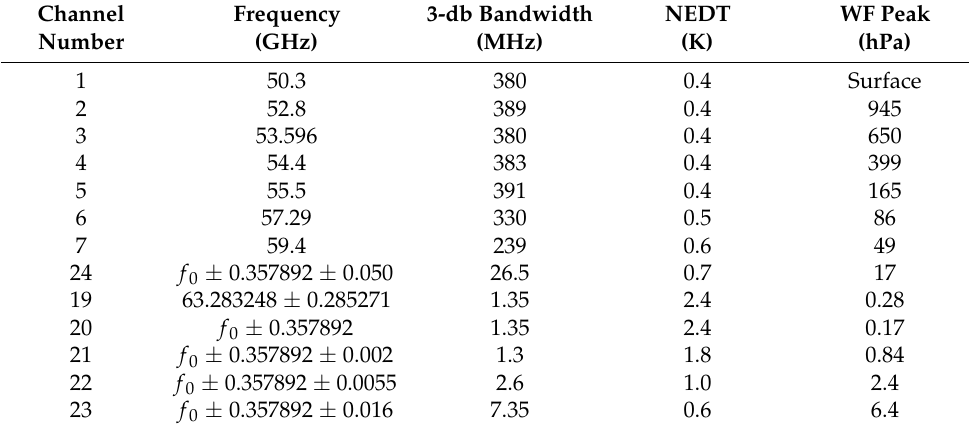
Table 1. SSMIS channel number, frequency, bandwidth, noise equivalent differential temperature (NEDT), and pressure at the level where WF reaches the maximum. The sampling interval is 12.5 × 37.5 km 2 for SSMIS channels 1–7 and 24 and 12.5 × 75 km 2 for channels 19–23, and the size of FOV is 27 × 18 km 2 , where the first and second numbers are in the along-track and across-track directions, respectively. The central frequency for channels 19–24 is f 0 = 60.792668.